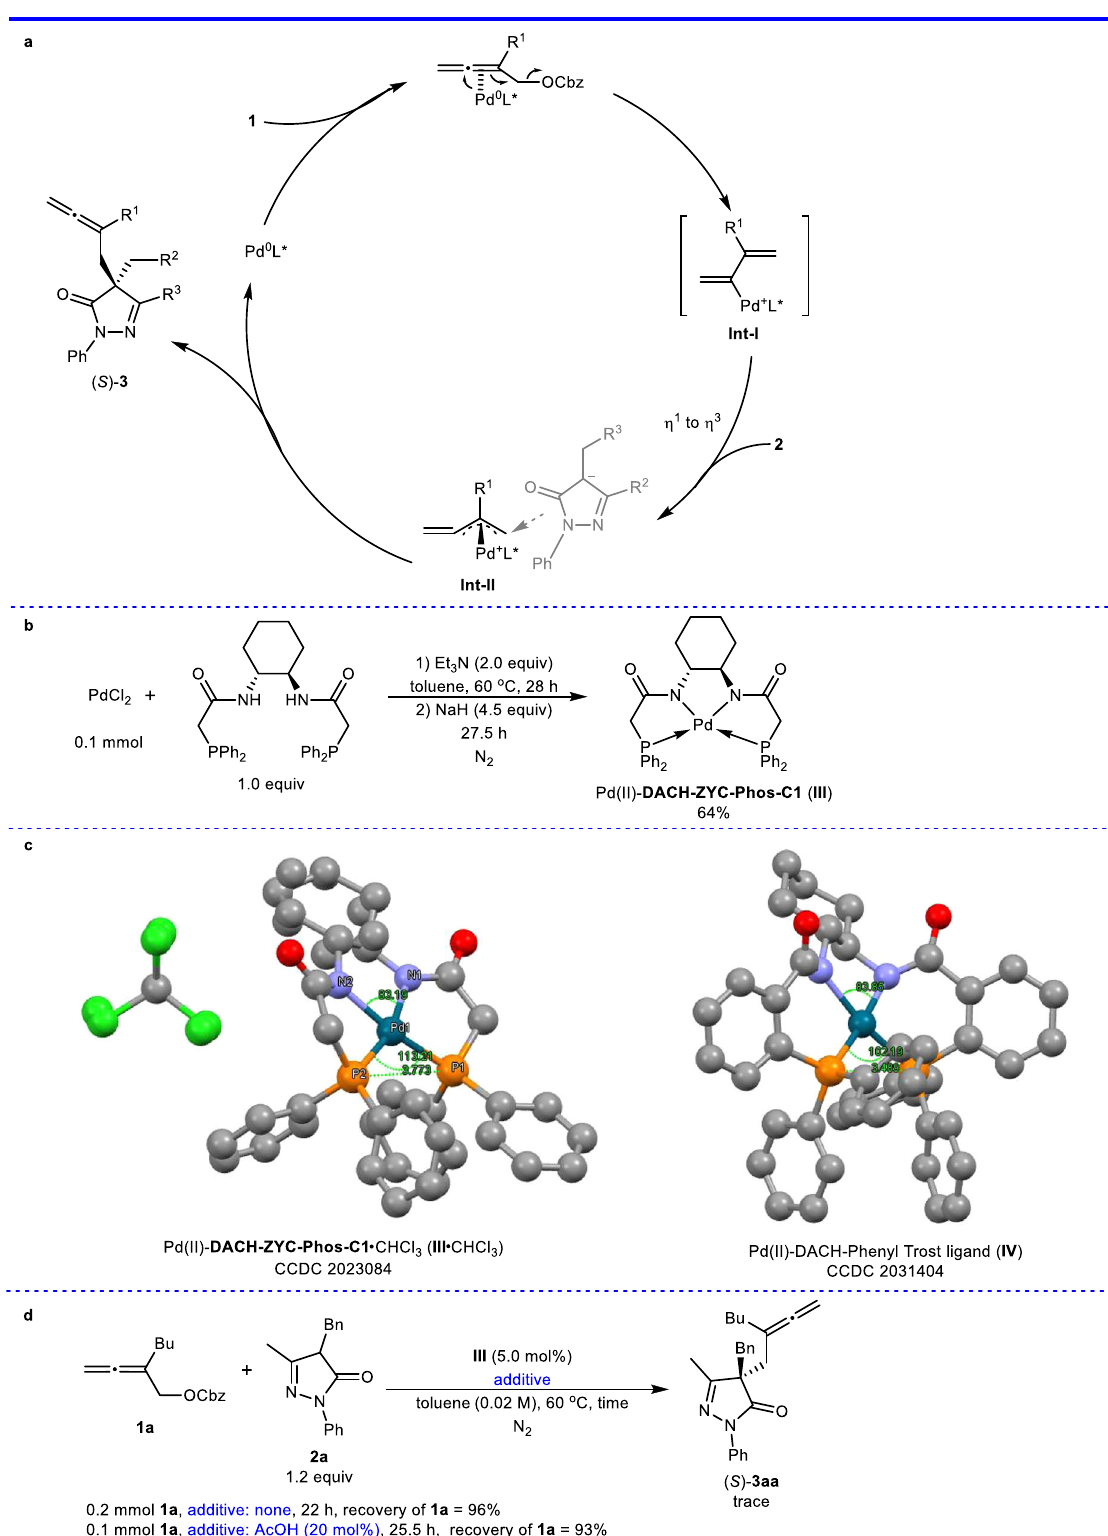
Fig. 5 A proposal mechanism and some experiments for Pd-ligand complexes. a A mechanism for the allenylation of pyrazolone. b Synthesis of Pd(II)- DACH-ZYC-Phos-C1 complex III . c ORTEP representations of Pd(II)-ligand complexes III and IV . H-atoms are omitted for clarity. d The reaction of pyrazolone 2a and allene 1a with complex III . Cbz benzyloxycarbonyl, DACH (1 R ,2 R